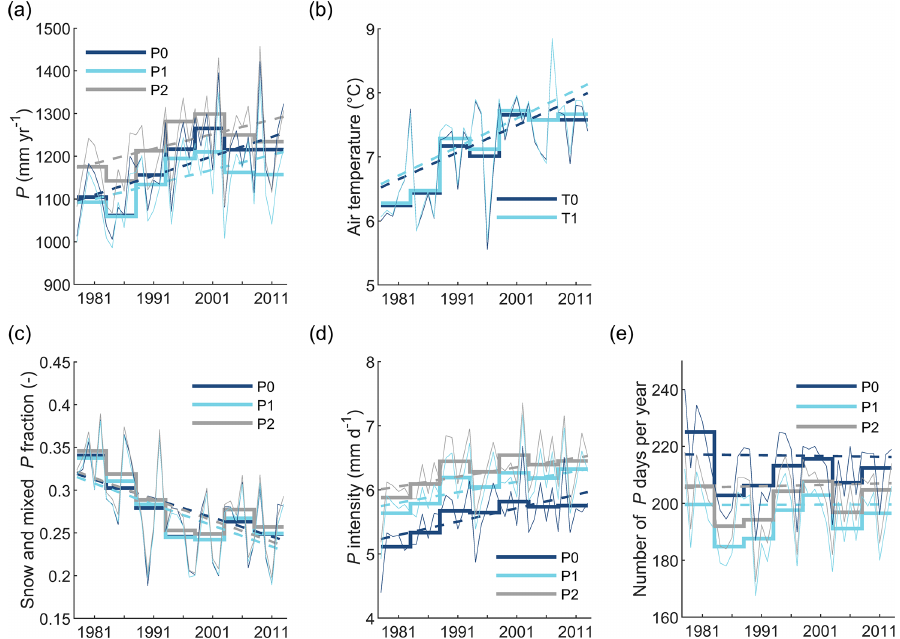
Figure 4. Temporal variations of (a) precipitation, (b) air temperature, (c) fraction of snow and mixed precipitation (estimated as precipitation on days with average daily air temperatures below 3 ◦ C), (d) precipitation intensity (precipitation day defined as day with precipitation ≥ 0 . 1mmd − 1 ), and (e) number of precipitation days per year as represented by different data sets and averaged over all catchments. The thick lines show subperiod means, the thin lines show annual sums and the broken lines show linear trends; the different colours represent different data sets. Precipitation data set P 0 is based on a variable number of stations over time, P 1 is based on a constant number of stations, and P 2 is based on a constant number of stations and includes a correction for undercatch. Air temperature data set T 0 is based on a variable number of stations, and T 1 is based on a constant number of stations.